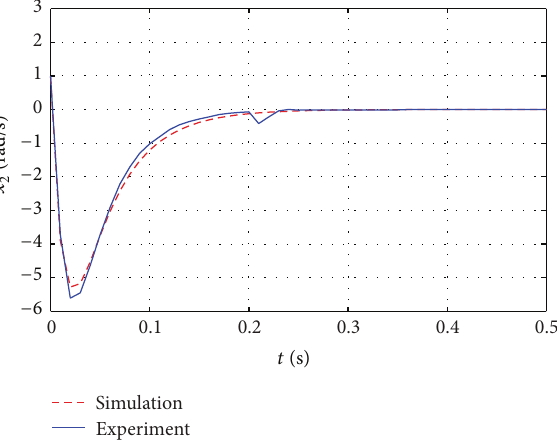
Figure 7: The state variable 𝑥 2